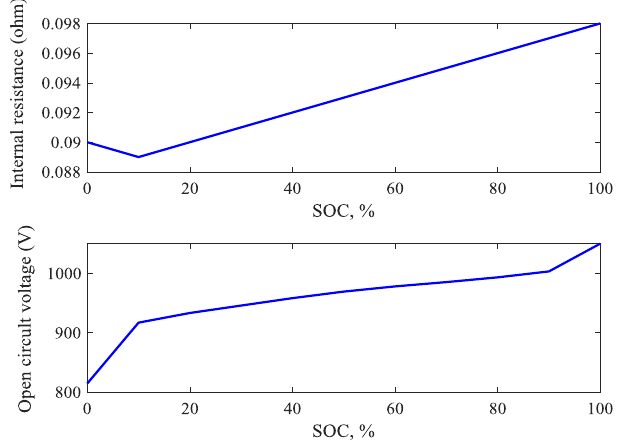
Figure 5. Map of the battery pack’s characteristics.